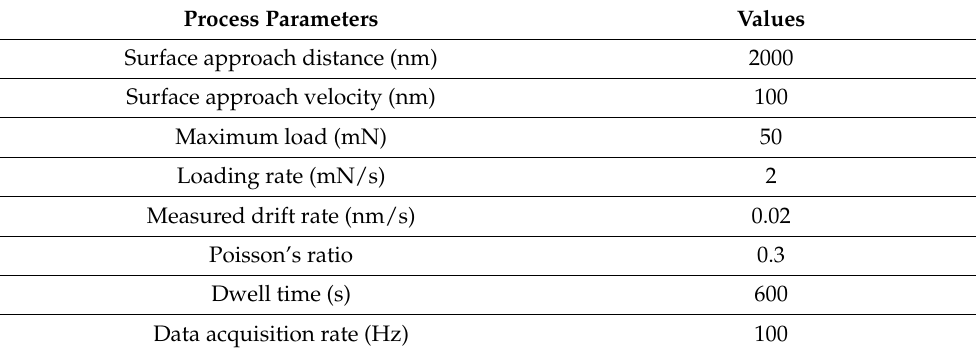
Table 2. Process parameters during the evaluation of indentation creep.